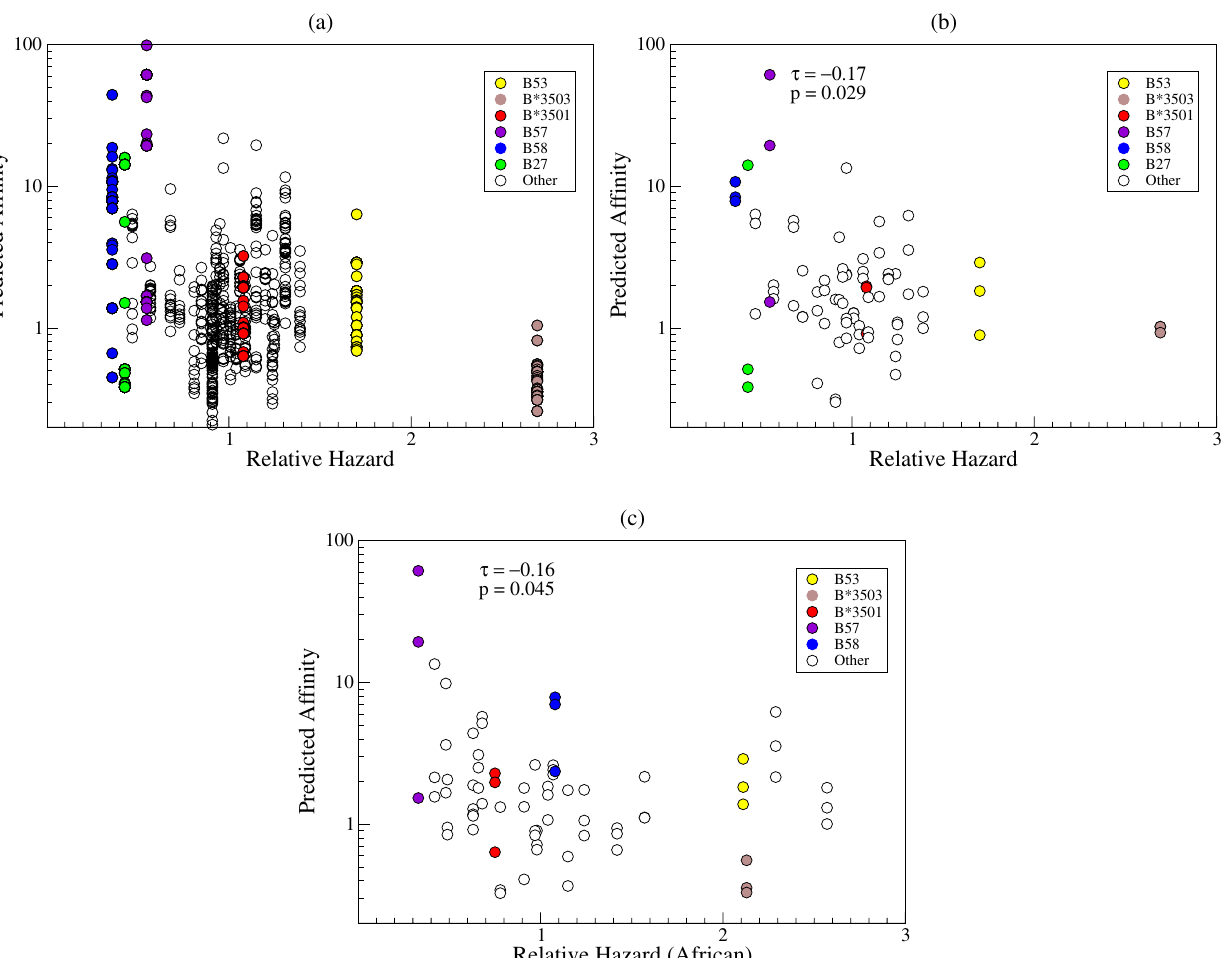
Figure 2. Relationship between relative hazard and predicted HLA-binding affinity for p24 epitopes. The relationship between the relative hazard of HIV-1 disease progression and the predicted affinity of p24 peptides plotted for different HLA alleles. The graphs show the normalized predicted affinity of the three best-binding p24 epitopes for each HLA allele. Data were based on (A) the Caucasian RH of 27 different HLA alleles [13] and 59 individual HIV-1 clade B sequences downloaded from the Los Alamos database, (B) the Caucasian RH of 27 different HLA alleles [13] and the consensus HIV-1 clade B sequence, and (C) the African RH of 24 different HLA alleles for which non-trivial RH have been determined [13] and the consensus HIV-1 clade C sequence. The RH values represent the relative hazard of the 2-digit HLA serotype (except for HLA-B3503 and B3501 for which separate RH are known [13]), while the predicted affinities were based on prediction tools for the 4-digit HLA allele that dominates the 2-digit HLA serotype (except for HLA-A0205 and HLA-B5802, which dominate the HLA serotypes HLA-A02 and HLA-B58 in Africans, but for which no high quality prediction tools are available; when they were omitted from the analysis in panel (C), the correlation remained significant ( p =0.014)). Because binding motifs of HLA molecules are not always independent, we repeated the analysis by randomly selecting only one peptide, when a peptide binds more than one allele. In all cases the analysis for HIV-1 clade B and clade C remained significant ( p , 0.02). All HLA-peptide binding predictions were based on matrix methods; very similar results were obtained when using NetMHC, or when we confined our analyses to the best-binding p24 peptide for each HLA type.